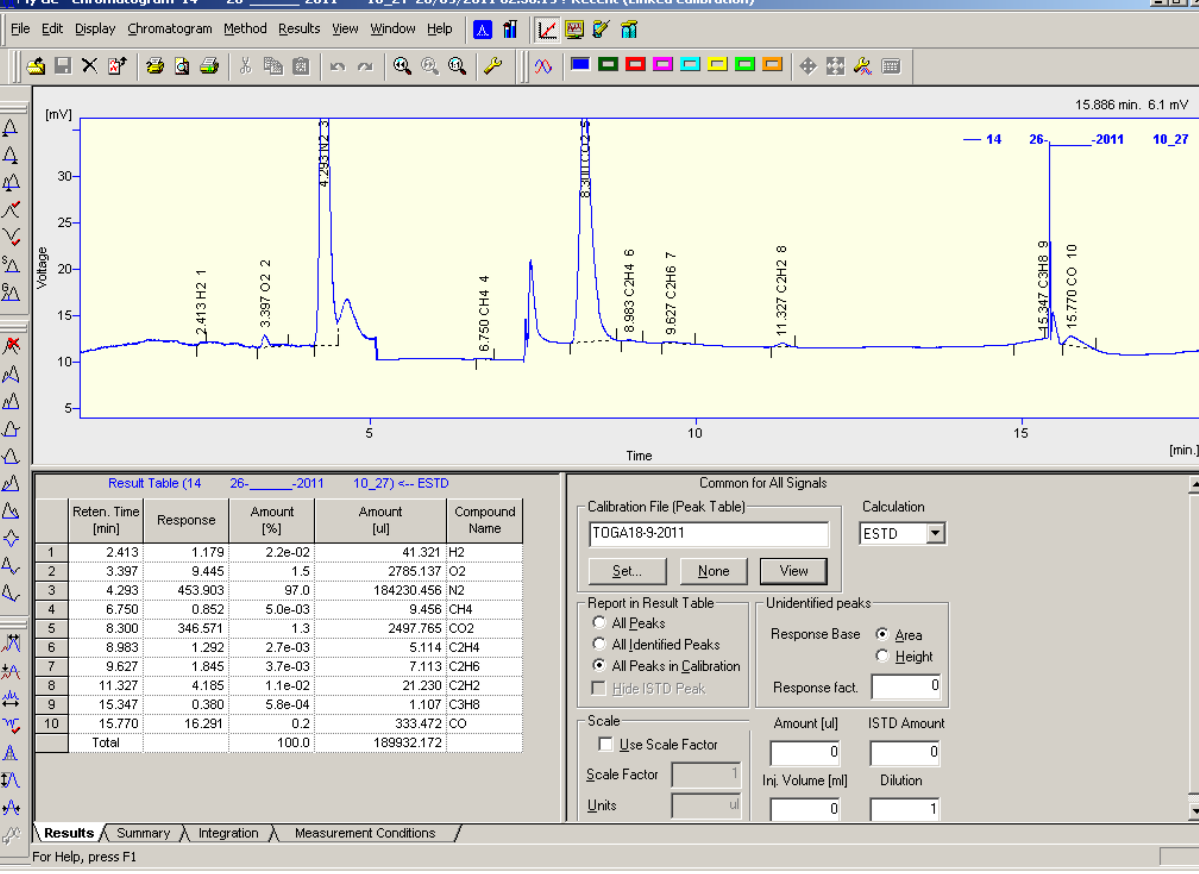
Figure 1. Analysis results of the dissolved gases using gas chromatography.